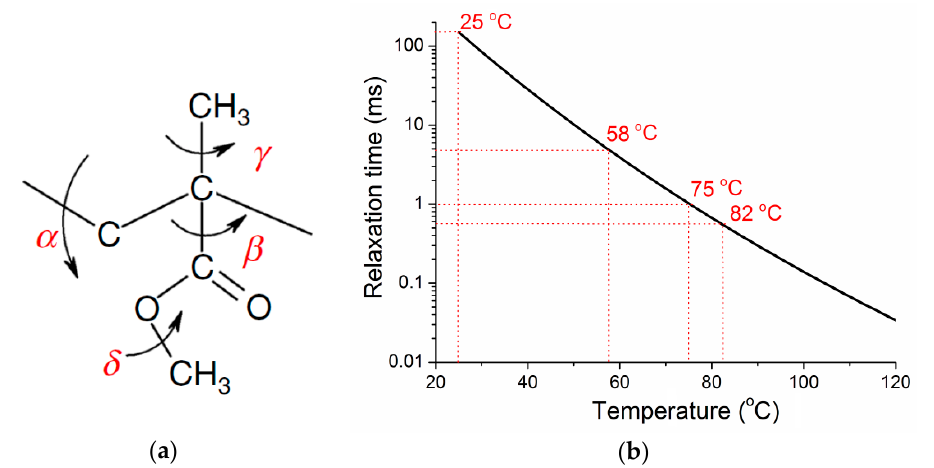
Figure 5. ( a ) The unit structure of PMMA; ( b ) The changes of β -relaxation time with